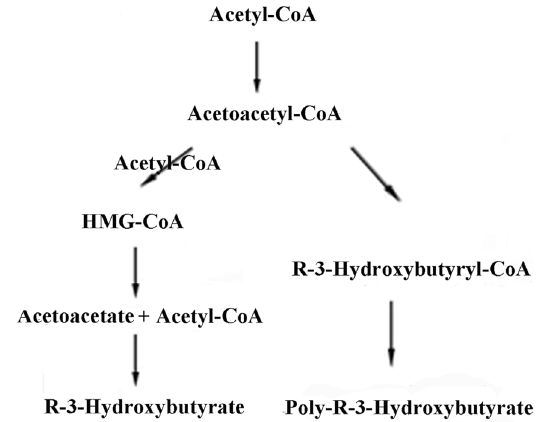
Figure 3. Biosynthetic pathways for PHB metabolites in prokaryotes and eukaryotes. In all organisms, acetoacetyl-CoA is formed by condensation of two acetyl-CoA. In prokaryotes ( right ), acetoacetyl-CoA is reduced by NADPH to R -3-hydroxybutyryl-CoA, which is then polymerized to PHB. In eukaryotes ( left ), a third acetyl-CoA condenses with acetoacetyl-CoA to form 3-hydroxy-3-methylglutaryl-CoA (HMG-CoA), which is subsequently decomposed to acetoacetate and acetate. Acetoacetate is then reduced by NADH to R